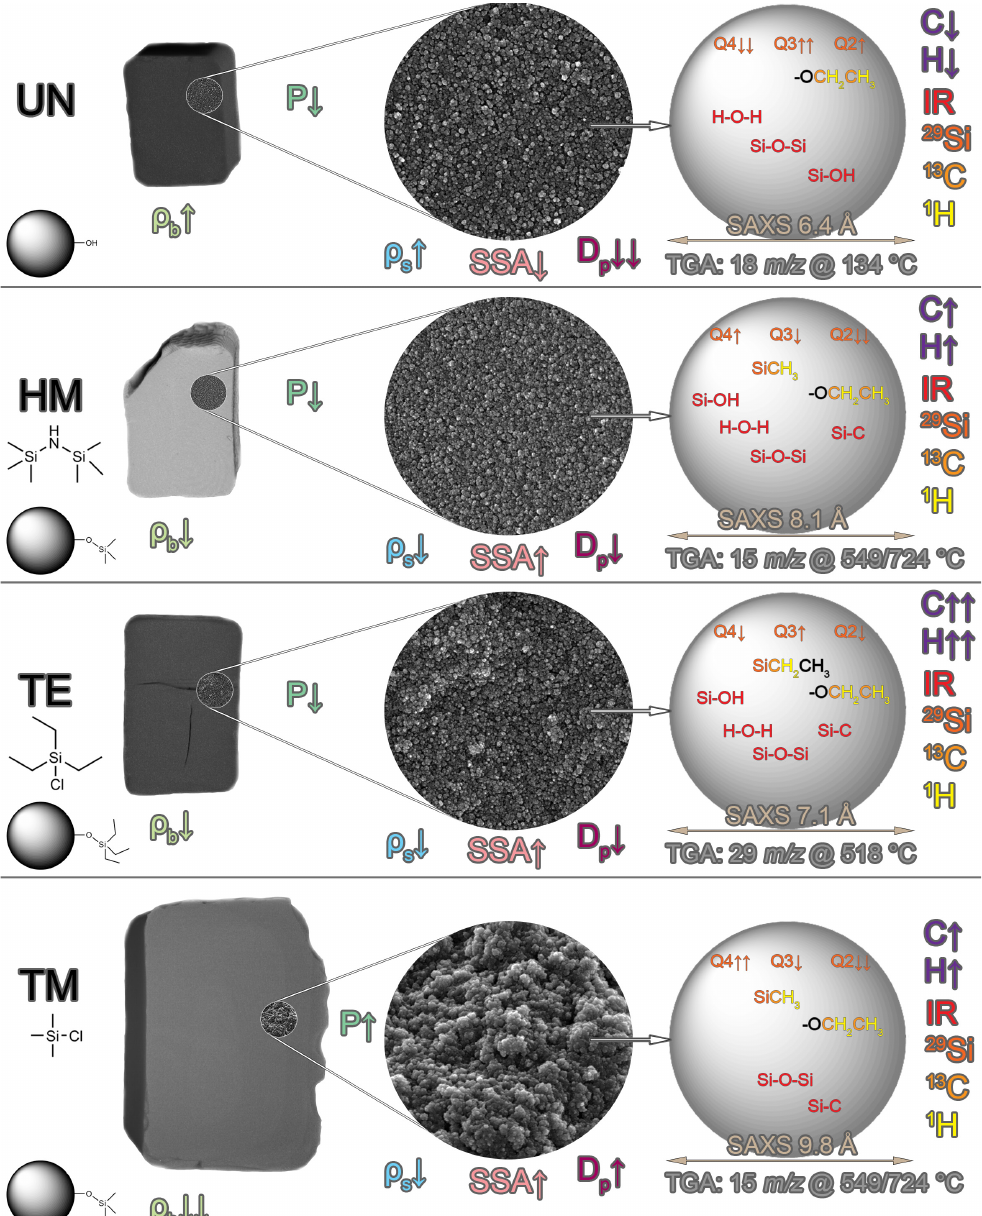
Figure 10. The main differences in drying behavior, chemical composition, density, porosity and microstructure between the unmodified UN, hexamethyldisilazane-modified HM, triethylchlorosilane-modified TE, and trimethylchlorosilane-modified TM silica gels. The chemical formulas of HMDS, TECS, and TMCS are visualized underneath HM, TE, and TM, respectively. Each sample shows the macroscopic structure as captured by µCT and the microscopic structure by SEM, as well as measured information about the primary particles. The comparison of the measured parameters is displayed as an arrow for each sample. From left to right, the following information is shown: bulk density ρ ρ s (blue), specific surface area SSA (pink), pore b (light green), porosity P (green), skeletal density size D p (magenta), carbon and hydrogen elemental analysis (purple), detected FTIR groups (red), detected 29 Si (dark orange), 13 C (orange), and 1 H (yellow) NMR spectra, primary particle size by SAXS (brown), and main TGA weight loss